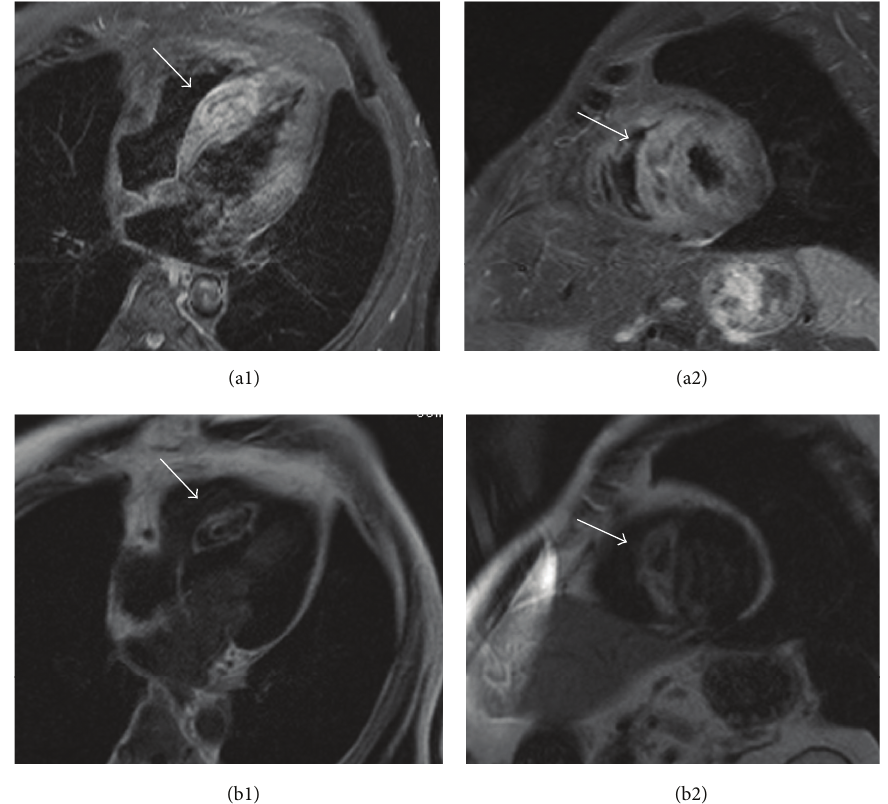
Figure 7: Interventricular septum with hematoma accompanied with microvascular obstruction by cardiac magnetic resonance (CMR) imaging performed 6 days after the index PCI. (a) T2-weighted image. (b) Late gadolinium enhancement (LGE)